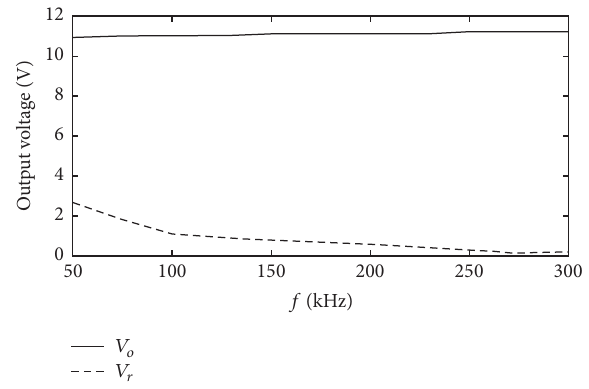
Figure 10: The output DC ( 𝑉 𝑜 ) and ripple ( 𝑉 𝑟 ) voltage versus frequency.